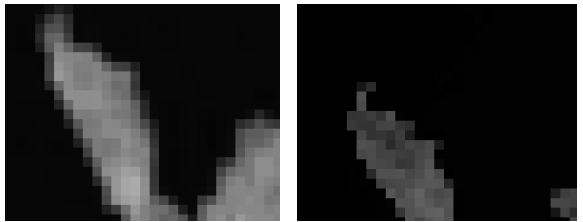
Figure 13. 2D displacement observed in MERIS RGB (red Figure 14. Parts of the produced reference data in GEOS band only, left) and MERIS L3 synthesis (B12, right) over Port projection and the SEVIRI HRV image over Sicily, Gentil area, Gabon, (zoomed view at MSG projection, 1 km GSD).